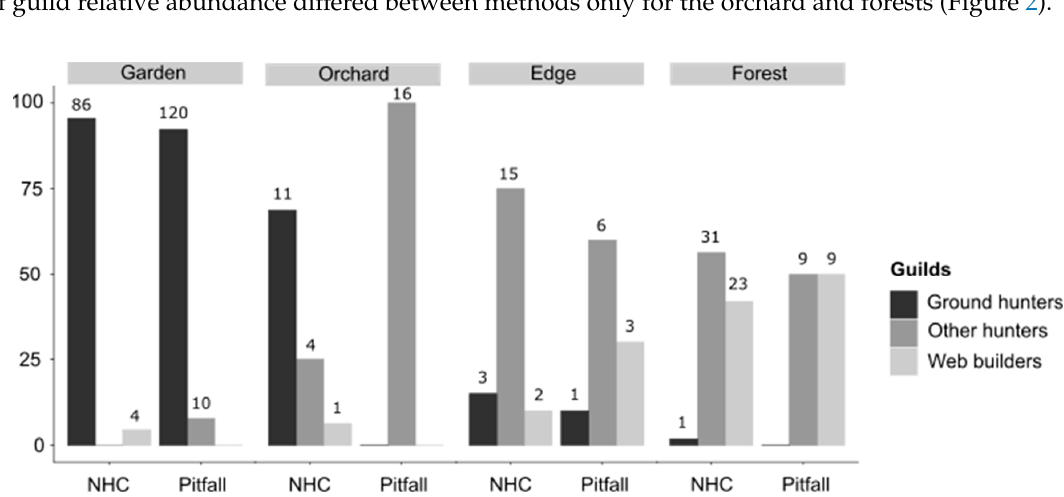
Table 3. Decomposition of beta diversity among habitats and by sampling method ( β : beta diversity; β TURN : partition of the beta diversity linked to turnover; β NEST : partition of the beta diversity linked to nestedness).